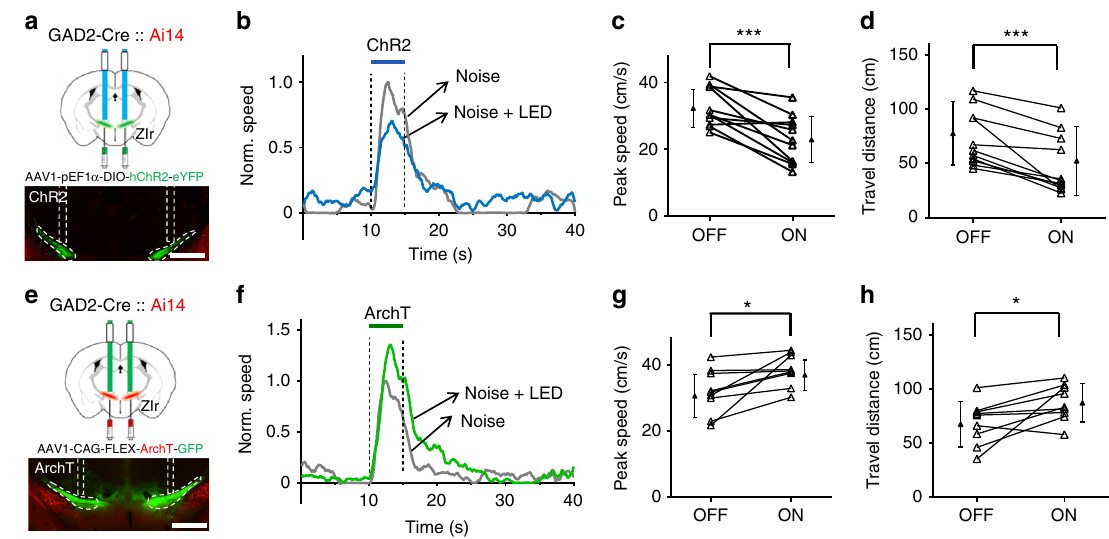
Fig. 2 ZIr bi-directionally modulates noise-induced fl ight response. a Upper, illustration of the experimental paradigm. Lower, image showing ChR2 expression (green) and placement of two optic fi bers over ZIr. Scale: 1000 µ m. b Normalized average speed induced by noise sound for an example ChR2- expressing animal with (blue) and without (gray) blue LED stimulation. Two dash lines mark the duration of noise. c Summary of noise-induced peak speed without (OFF) and with (ON) activation of ZIr neurons. *** p = 0.001, two-sided paired t -test, n = 11 animals. d Summary of total travel distance during the 5-s noise stimulation without and with activation of ZIr neurons. *** p = 0.003, two-sided Wilcoxon signed-rank test, n = 11. e Upper, illustration of the experimental paradigm. Lower, image showing ArchT expression (green) and placement of two optic fi bers over ZIr. Scale: 1000 µ m. f Normalized average speed induced by noise for an example ArchT-expressing animal with (green) and without (gray) green LED stimulation. g Summary of noise-induced peak speed without and with suppressing ZIr neurons. * p = 0.019, two-sided paired t -test, n = 9 animals. h Summary of total travel distance without and with suppressing ZIr. * p = 0.032, two-sided paired t -test, n = 9 animals. Solid symbol represents mean ± s.d. for all panels